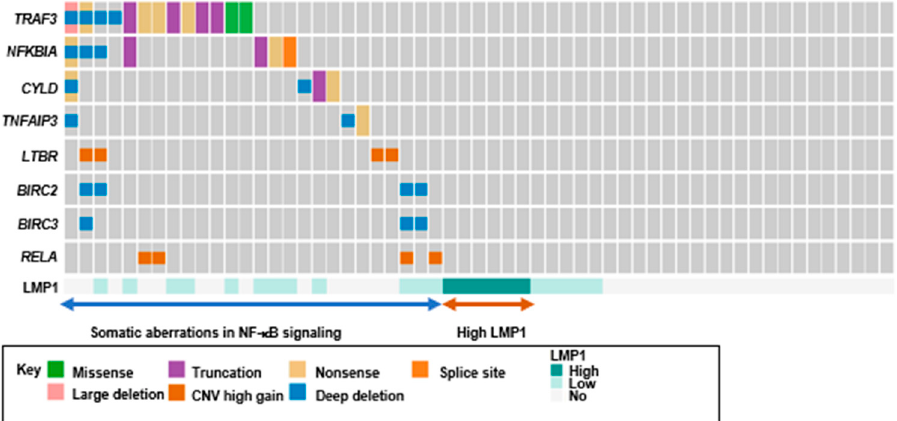
Figure 5. Genetic alterations altered in the NF- κ B pathway and expression of viral protein LMP1 in pulmonary lymphoepithelioma-like carcinoma. Genomic alterations in the NF- κ B pathway and high expression of LMP1 occurred mutually exclusively in pulmonary LELC. LELC, lymphoepithelioma-like carcinoma; LMP1, latent membrane protein 1. CNV, copy number variation.